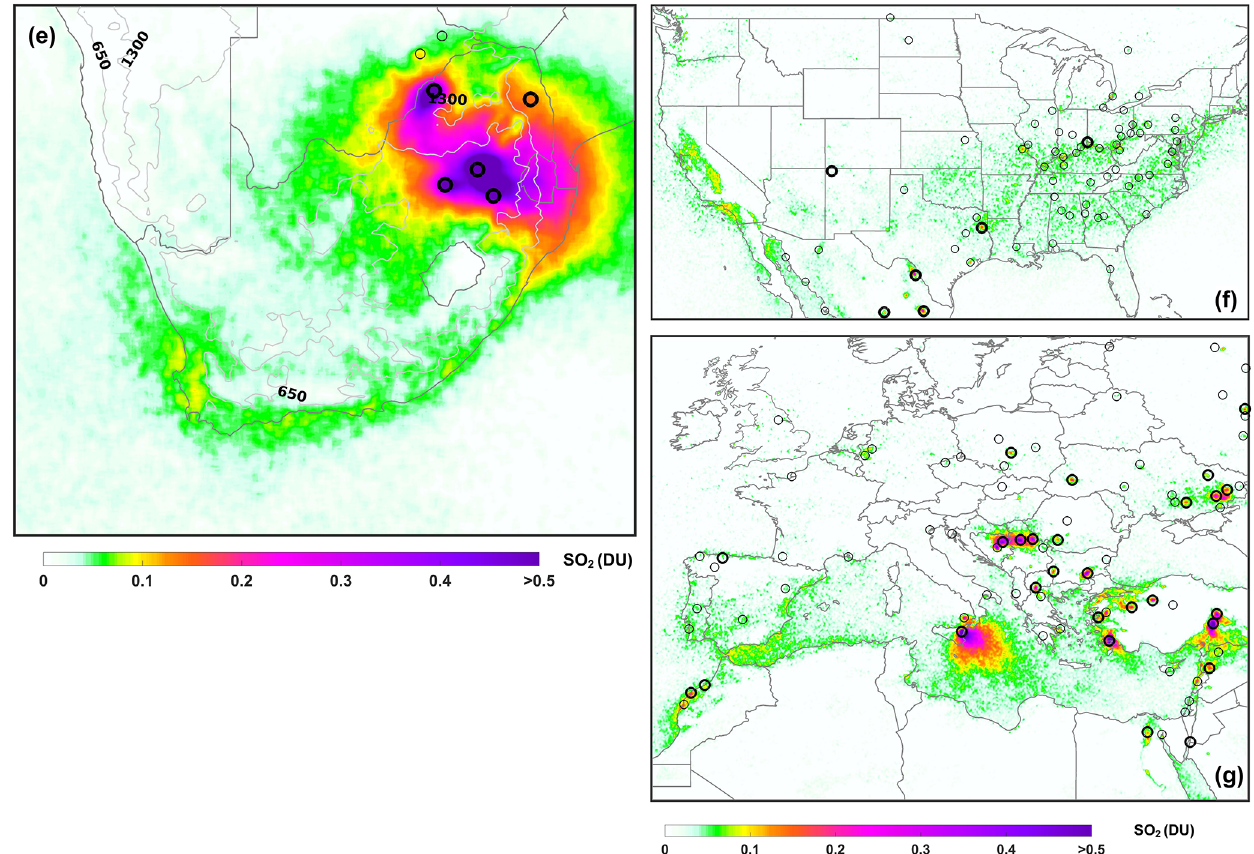
Figure 6. Averaged SO 2 column (in DU) for April 2018 to December 2020 over (a) eastern China, (b) India, (c) the Middle East, (d) South America, (e) South Africa, (f) the US and (g) Europe. The black circles mark the locations of SO 2 sources detected by OMI (in bold for the 2018–2019 period; see text). Due to the massive eruption of Raikoke on 21 June 2019, all data in the Northern Hemisphere, for the 3-month period after the eruption, are filtered out. The grey lines in (e) are the topography isolines (in metres) Note that to further reduce the data scatter, the SO 2 map was smoothed by a 2-dimensional 20-point box car function (instead of 10-point function for the other